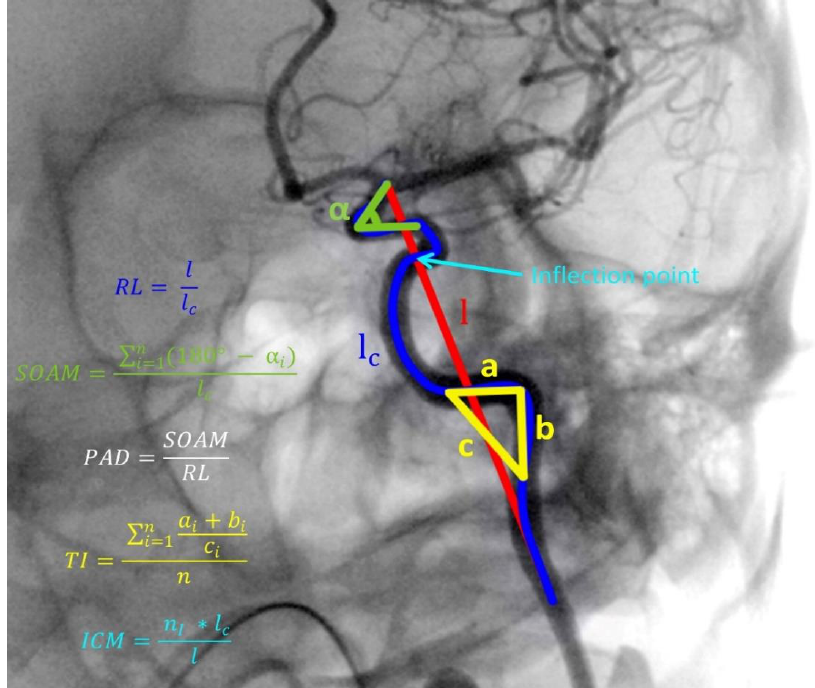
Figure 1. Illustration of internal carotid artery (ICA) tracking and tortuosity descriptors calculation. RL, Relative Length; SOAM, Sum of Angle Metrics; PAD, Product of Angle Distance; TI, Triangular Index; ICM, Inflection Count Metrics; n , number of angles on ICA course; an d n i , number of inflection points on ICA course. Marked angle, triangle, and inflection point are exemplary and are applicable to all parts of the artery. l, length of straight line between starting and ending point of analyzed artery segment; l c , absolute length of analyzed artery segment; a, b and c, sides of triangle constructed on angle of analyzed artery segment ; α, angle of analyzed artery segment.